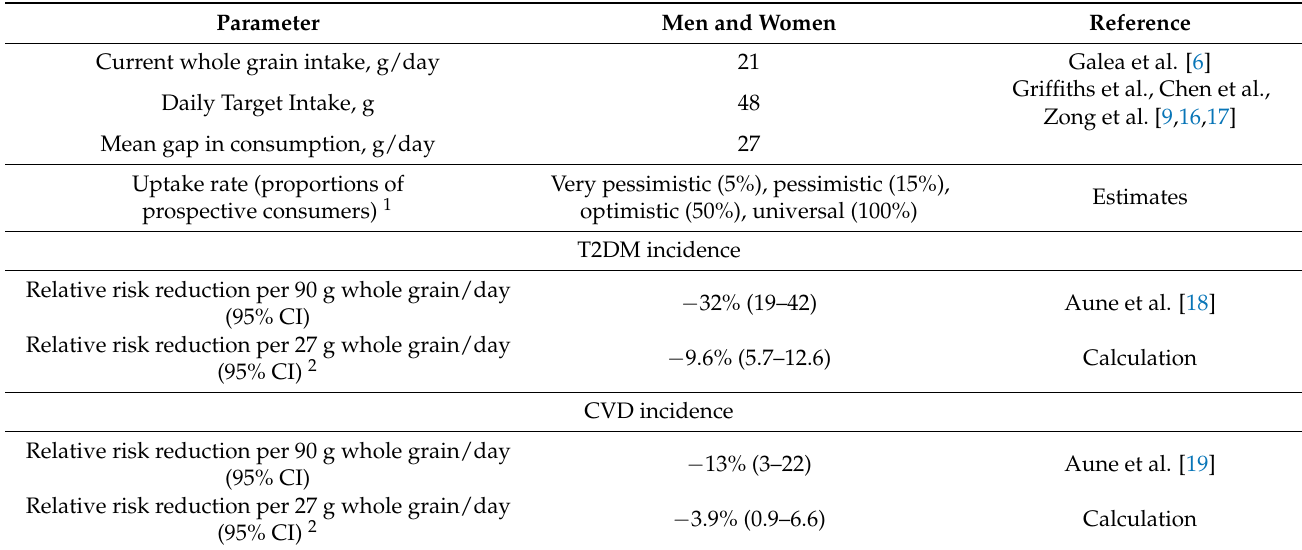
Table 1. Summary of the cost-of-illness analysis input parameters and corresponding